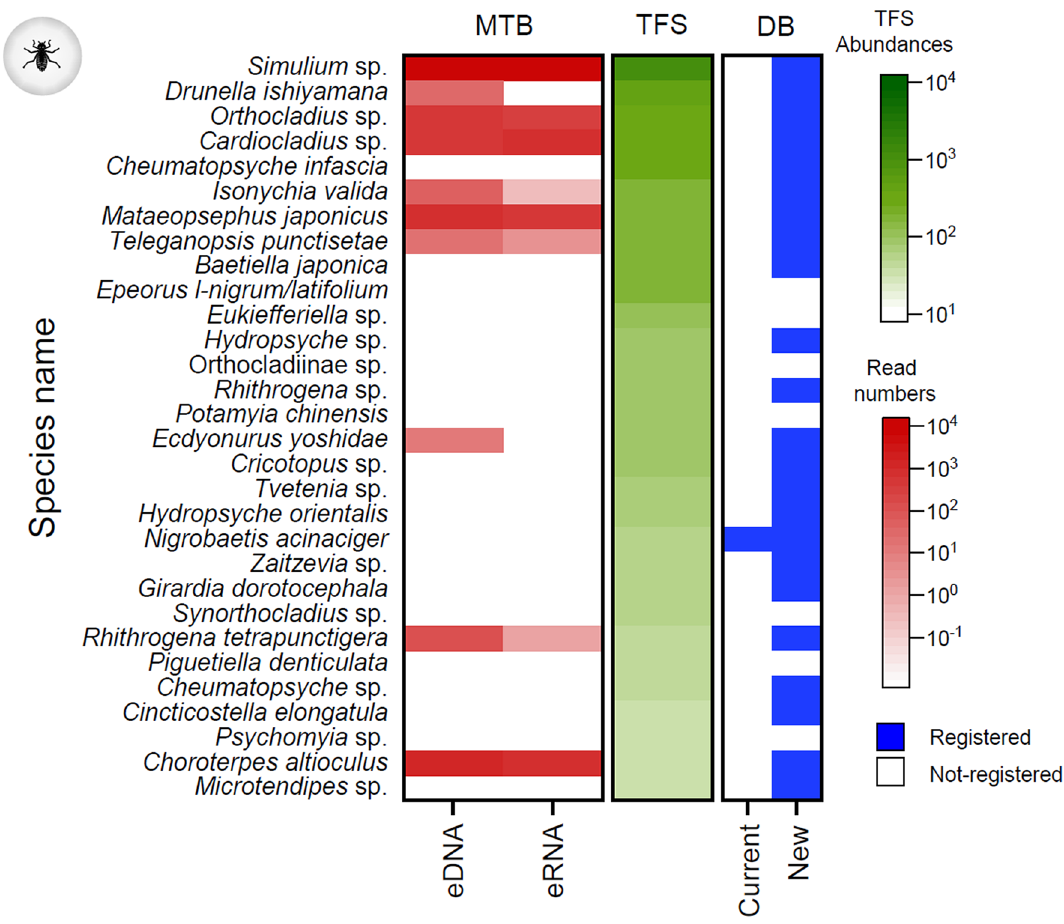
Figure 4. The 30 arthropod species with the greatest abundance detected in traditional field surveys and their read numbers in metabarcoding analysis. MTB: metabarcoding analysis, TFS: traditional field survey,